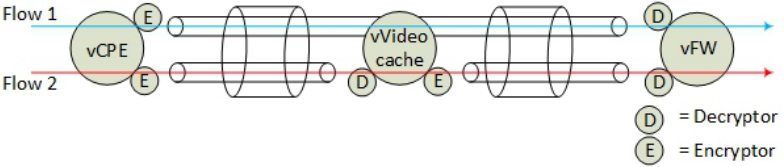
Figure 10. Flow-based encryption test in episode